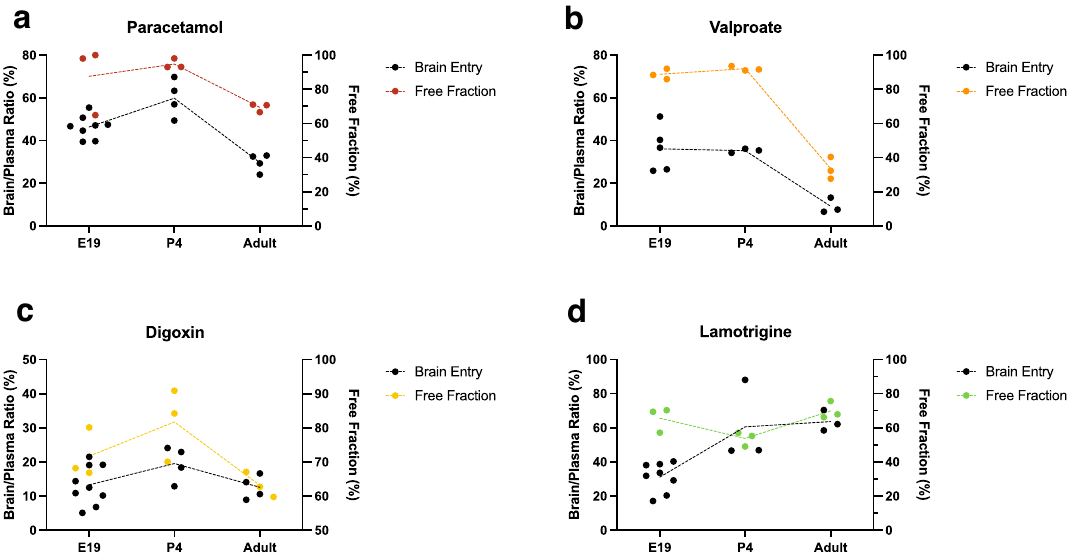
Figure 6. Plasma protein binding and brain entry of drugs in E19, P4 and non-pregnant female adult rats. Protein-free fraction/whole plasma concentration ratios (%) (black, left y-axis) and brain/plasma ratios (%) (colour, right y-axis) of paracetamol ( a ) , valproate ( b ) , digoxin ( c ) and lamotrigine ( d ). Brain entry results obtained from 35 (paracetamol & digoxin), and 37 (valproate &